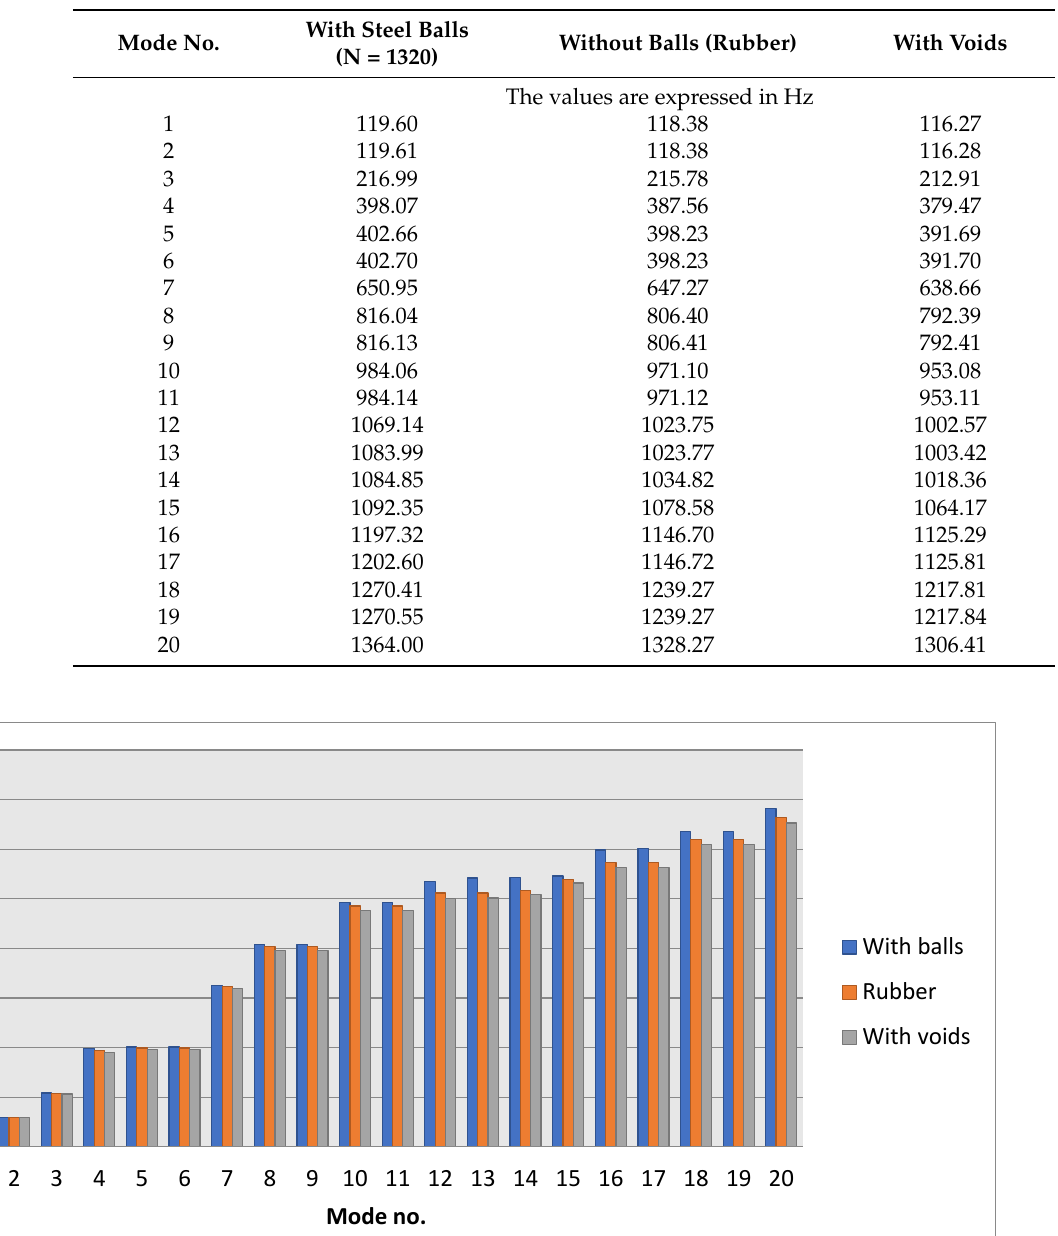
Table 3. The eigenpulsations for three different cases (N = 1320).